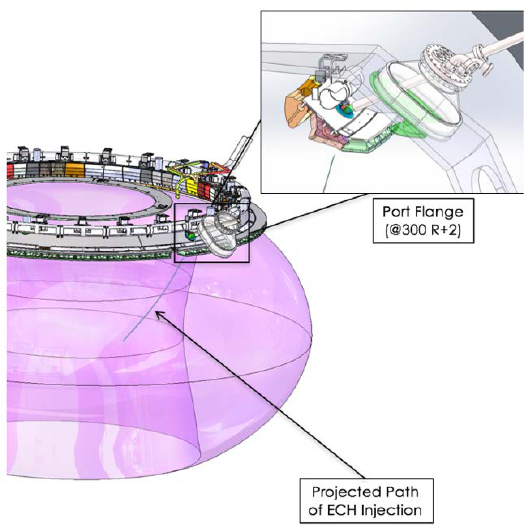
Figure 9: Preliminary design of the prototype fix-injection top launch